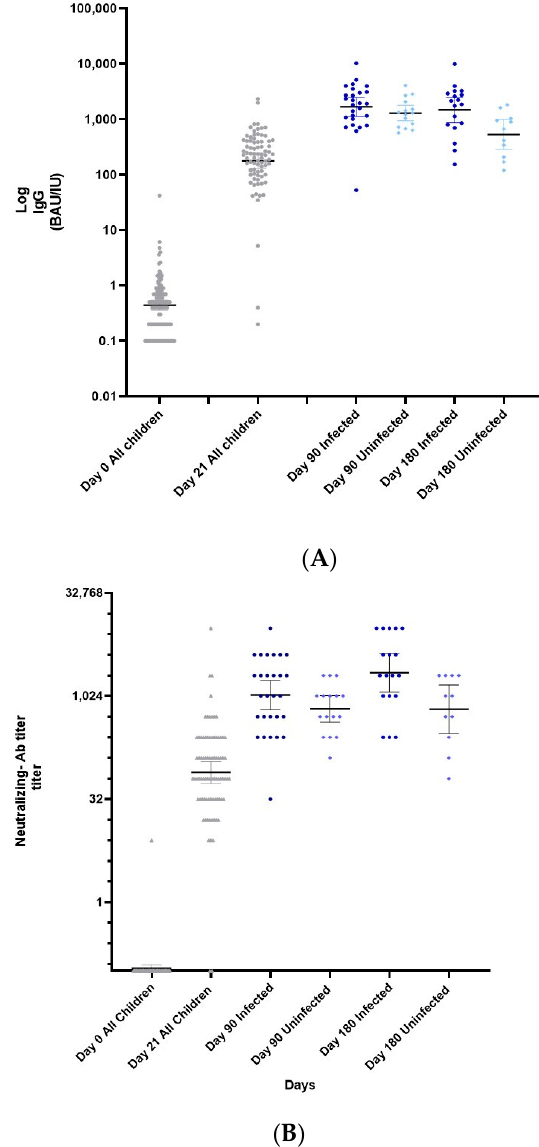
Figure 1. ( A ) GeoMean (CI 95%) of IgG antibodies against the SARS-CoV-2 spike RBD titer of infected and uninfected children at day 0, 21, 90, and 180. ( B ) GeoMean (CI 95%) of neutralizing Ab of Infected and uninfected children at day 0, 21, 90, and 180.